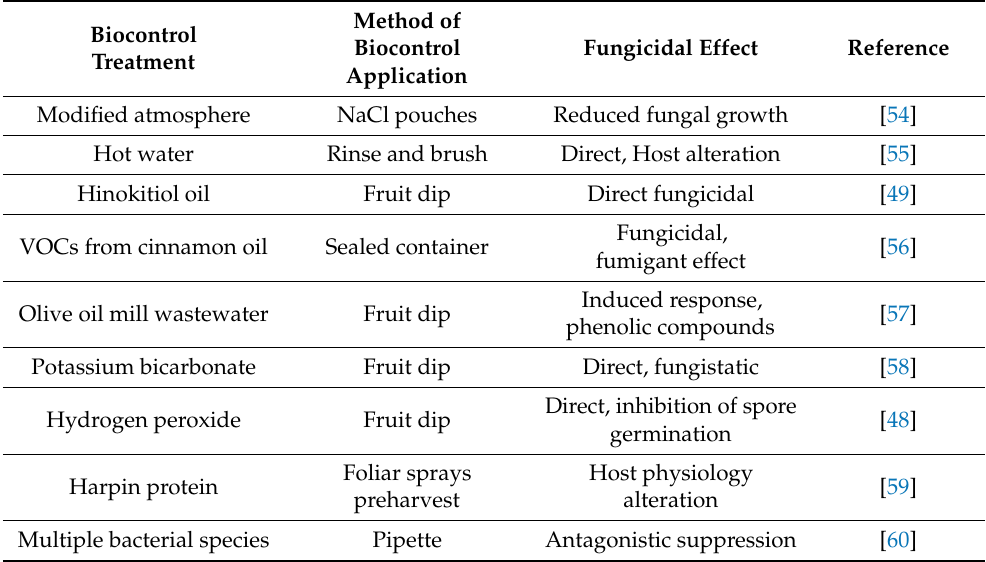
Table 1. Reports of physical, chemical, microbial, or environmental treatments effective against gray mold of bell pepper ( Capsicum annuum L.)